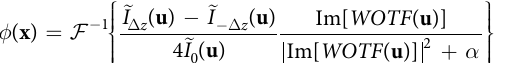
Figure 4. The imaginary part of WOTF (phase WOTF) when the source is a narrow annulus ( NA obj = 0.8, λ = 550 nm, the spatial frequency coordinate is normalized against the coherent resolution limit NA s = 0.1; ( b ) s = 0.4; ( c ) s = 0.75; ( d ) s =